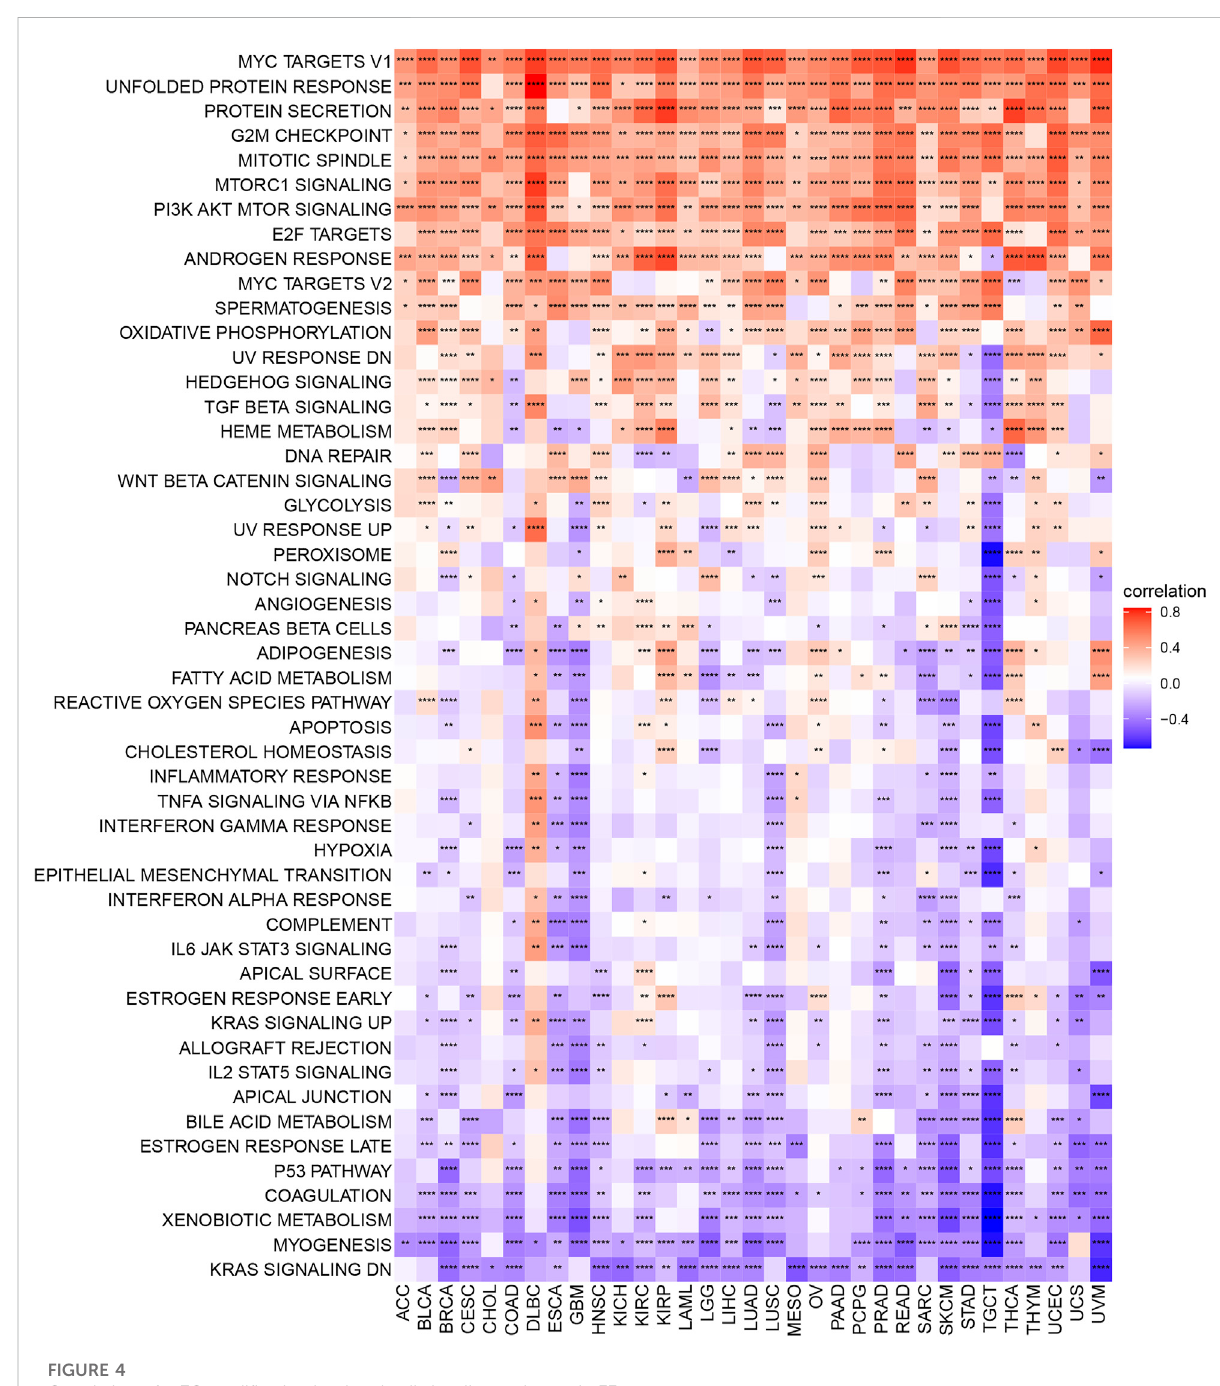
FIGURE 4 Correlation of m7G modi fi cation level and cell signaling pathways in 33